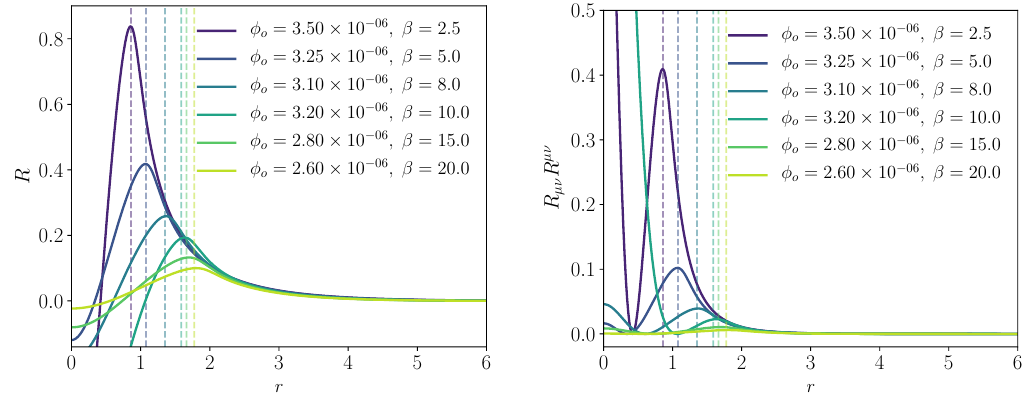
Figure 6 . Curvature scalar R and Ricci tensor squared R (cid:22)(cid:23) R (cid:22)(cid:23) as a function of the radial radius r at last moment t before formation of the sonic horizon for various values of (cid:12) and (cid:30) 0 corresponding to the (cid:12)rst branch. The vertical line represents the position of the sonic